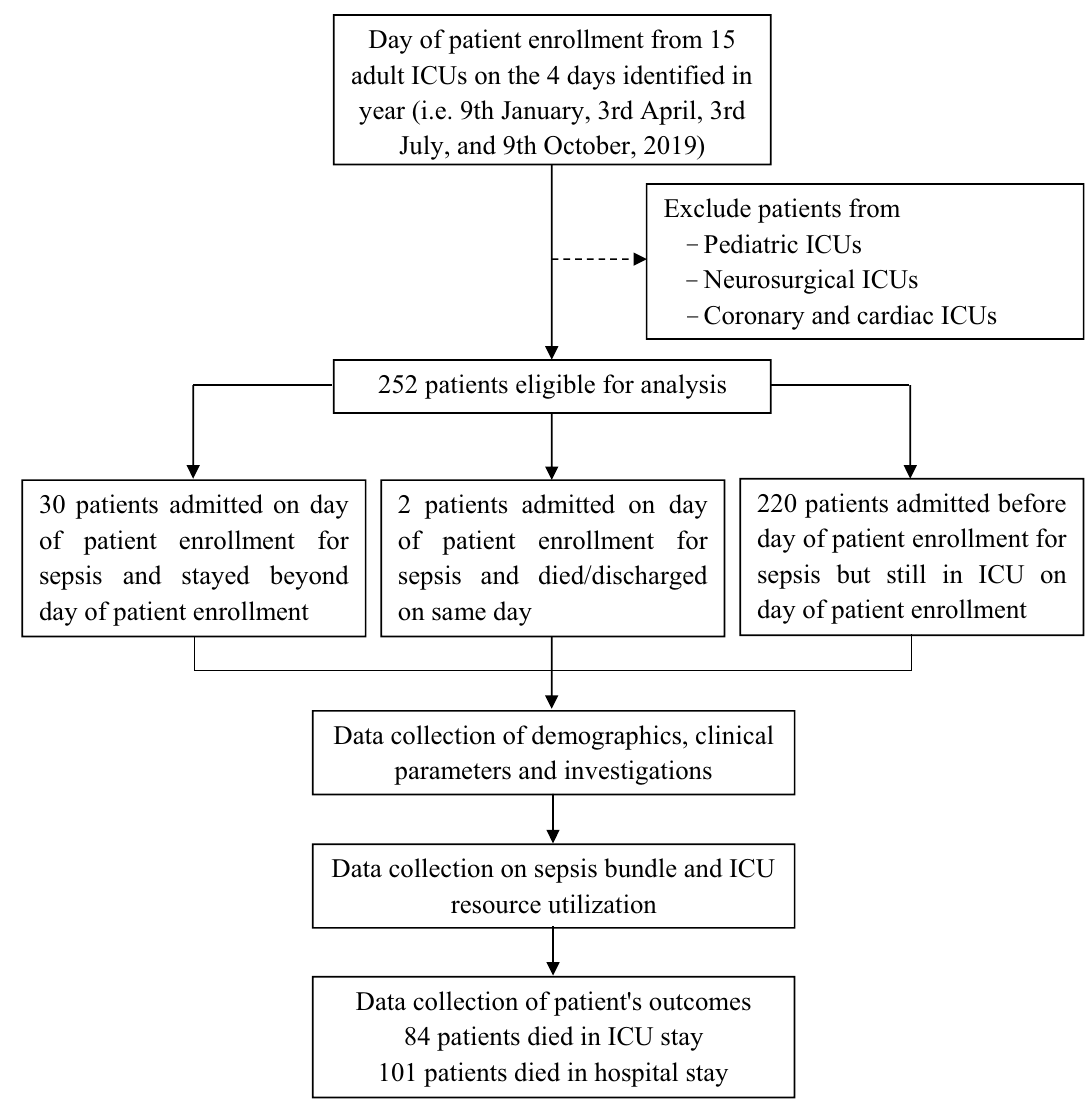
Figure 1. Flowchart of the study design, patient enrollment and follow up. ICU intensive care